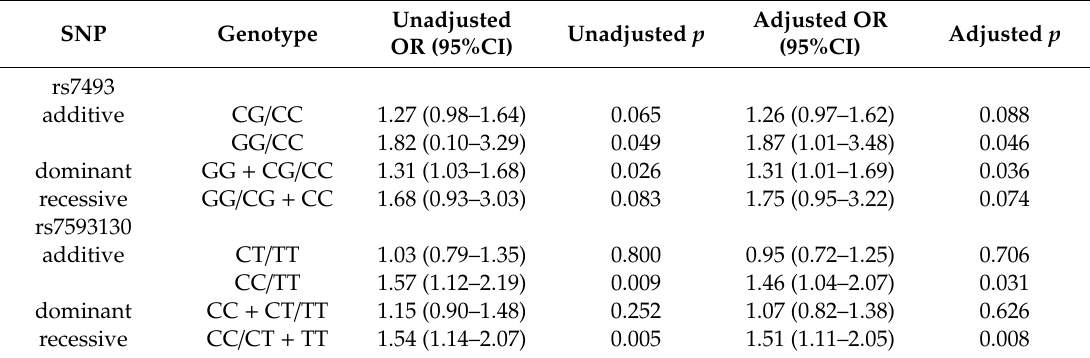
Table 2. Associations of genetic models with risk of non-alcoholic fatty liver disease (NAFLD).